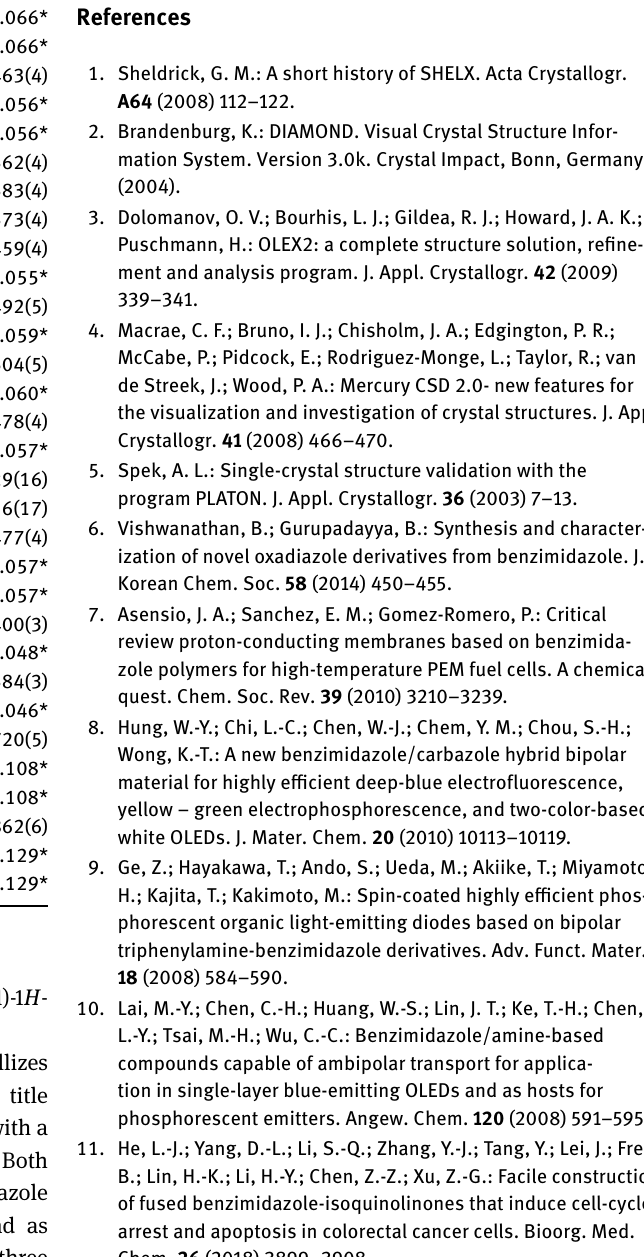
As shown in the figure, the title compound crystallizes in P 2 1 / c group with two crystal water molecules. The title compound is a 2-substituted benzimidazole derivative with a 4-piperidyl group, which adapts a boat conformation. Both the N atoms from the 4-piperidyl group and the imidazole group are protonated. The protonated title compound as a dication, is countered by two chlorides. There are